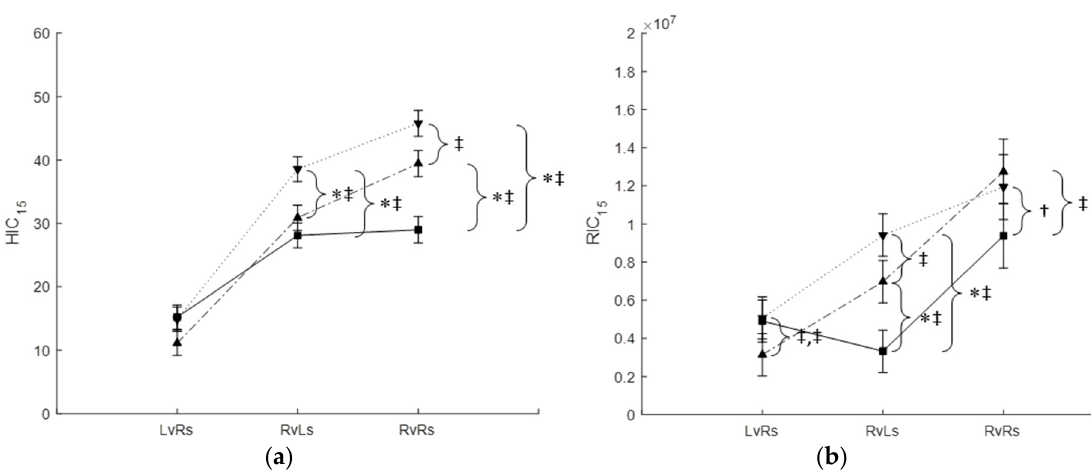
Figure 3. HIC 15 ( a ) and RIC 15 ( b ) for S4 ( ∎ ), S5L ( ▲ ), and S5 ( ▼ ) footballs for LvRs Traj , RvLs Traj , and RvRs Traj trajectory impacts. RIC 15 magnitudes are × 10 7 . * Significant difference between footballs ( P < 0.05). † and ‡ indicate moderate and large between football effect sizes,